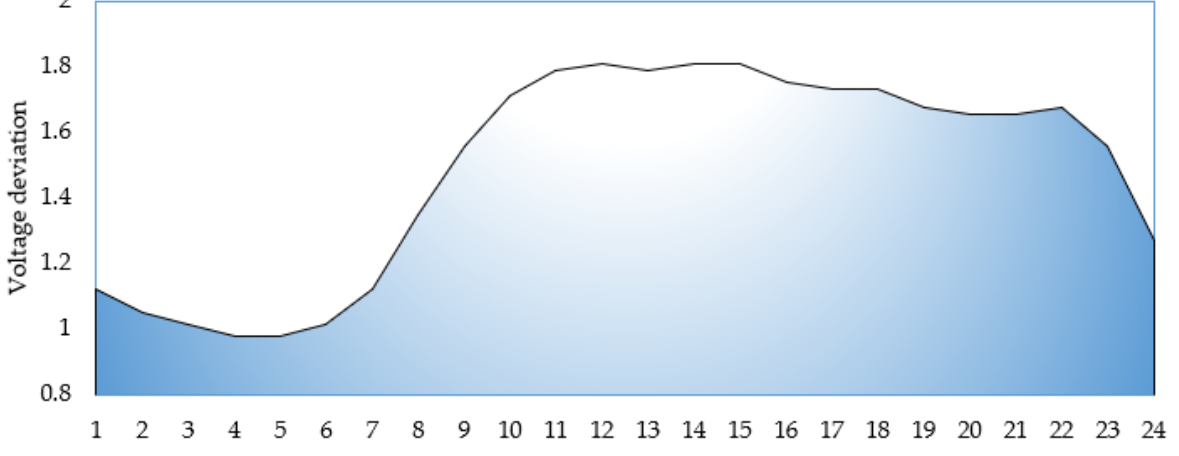
Figure 6. Hourly voltage deviations for the first scenario for the IEEE 33-distribution system.